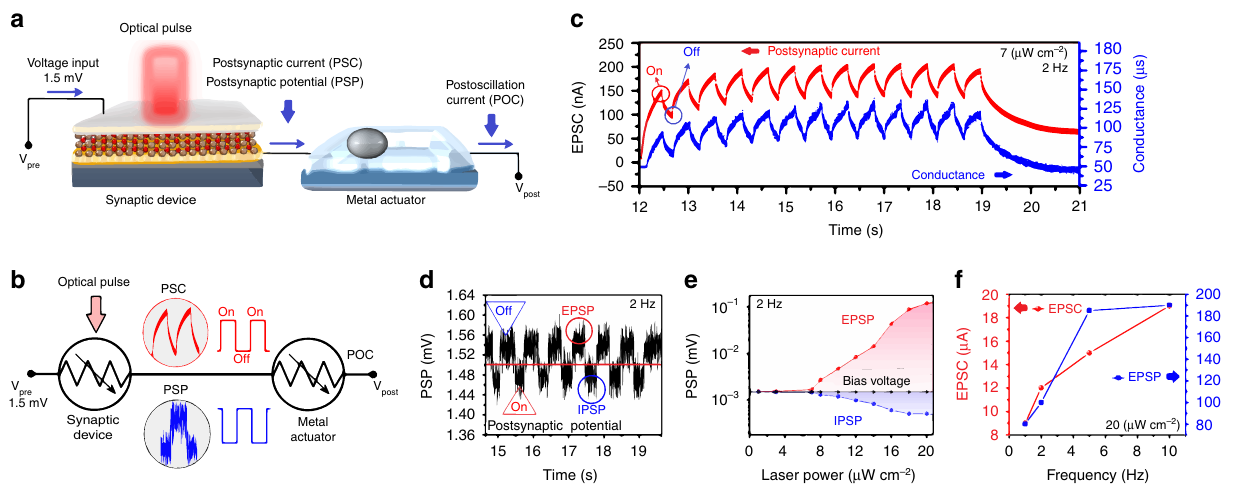
Fig. 3 The sensorimotor system and its optoelectronic characteristics of synaptic device. a The scheme of sensorimotor system and b corresponding circuit. c A typical EPSC and conductance variation for ITO/In-doped TiO 2 /Au device illuminated by 7 μ W cm − 2 pulsed light (530nm, 2 Hz) and d the corresponding variation of PSP of the same device. e The variation of PSP vs. the laser light intensity. f The variation of EPSC and EPSP vs. frequency of pulsed